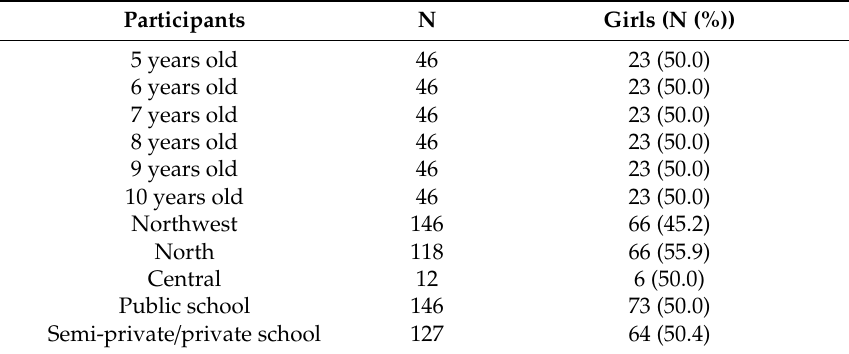
Table 1. Characteristics of the psychometric validation participants ( n =